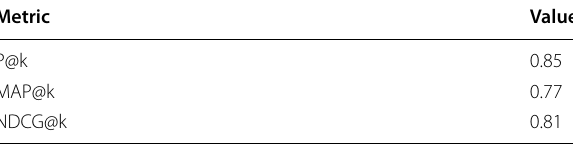
Target code Relevant percentage Relevant percentage of recommendation recommendation of recommended recommended target domain code